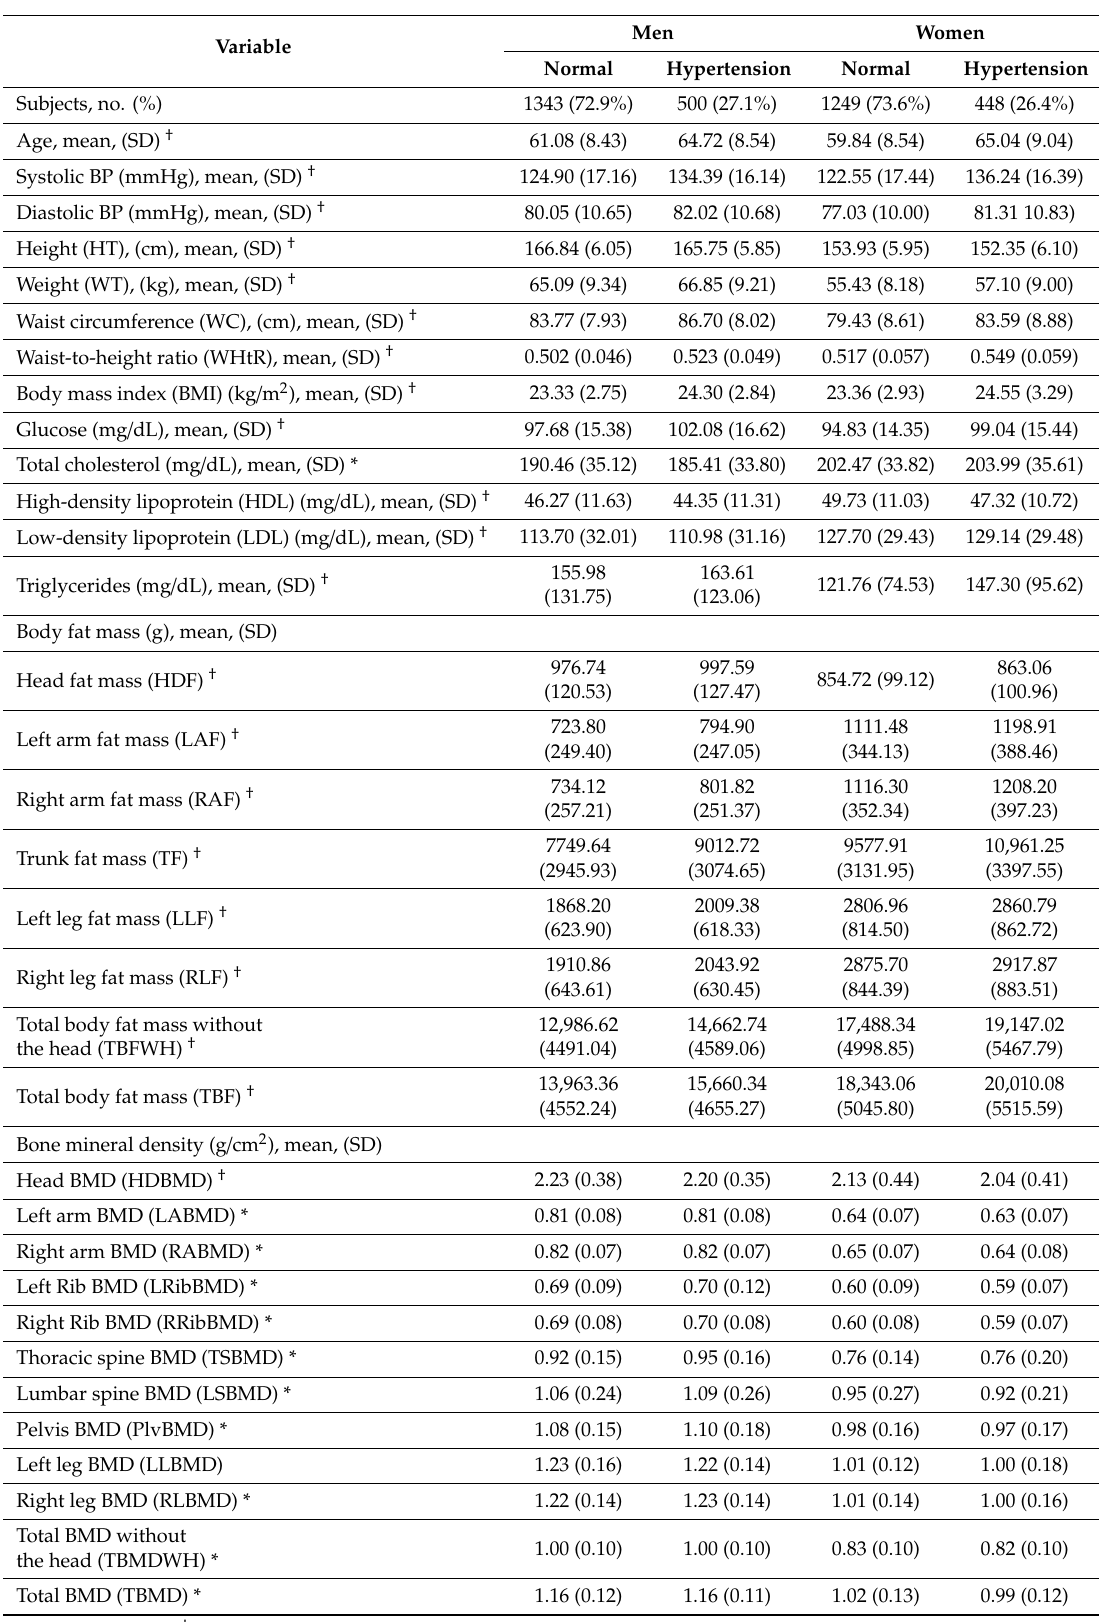
Table 1. Basic characteristics of all variables for